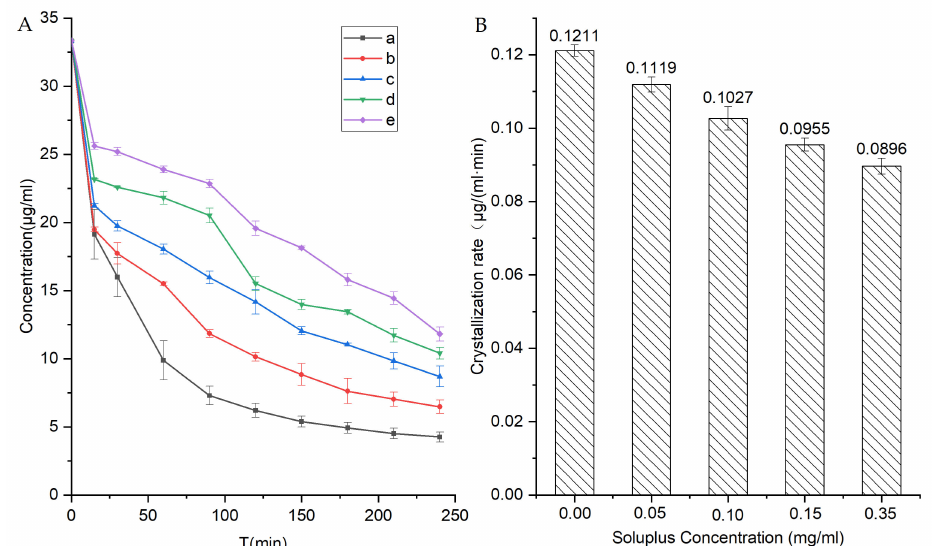
Figure 12. ( A ) Inhibition effects of Soluplus ® on the recrystallization of NIT from a supersaturated concentrated solution (33.33 µ g/mL) at 37 ◦ C in PBS (pH 6.8) (a) and mixed with Soluplus ® at different concentrations of 0.05 (b), 0.1 (c), 0.15 (d), or 0.35 mg/mL (e). ( B ) The relationship between crystallization rate and Soluplus ® concentration. Standard deviations are expressed as error bars ( n = 3). Table 2. Half-time (T1/2) of recrystallization of crystalline NIT from a supersaturated concentrated